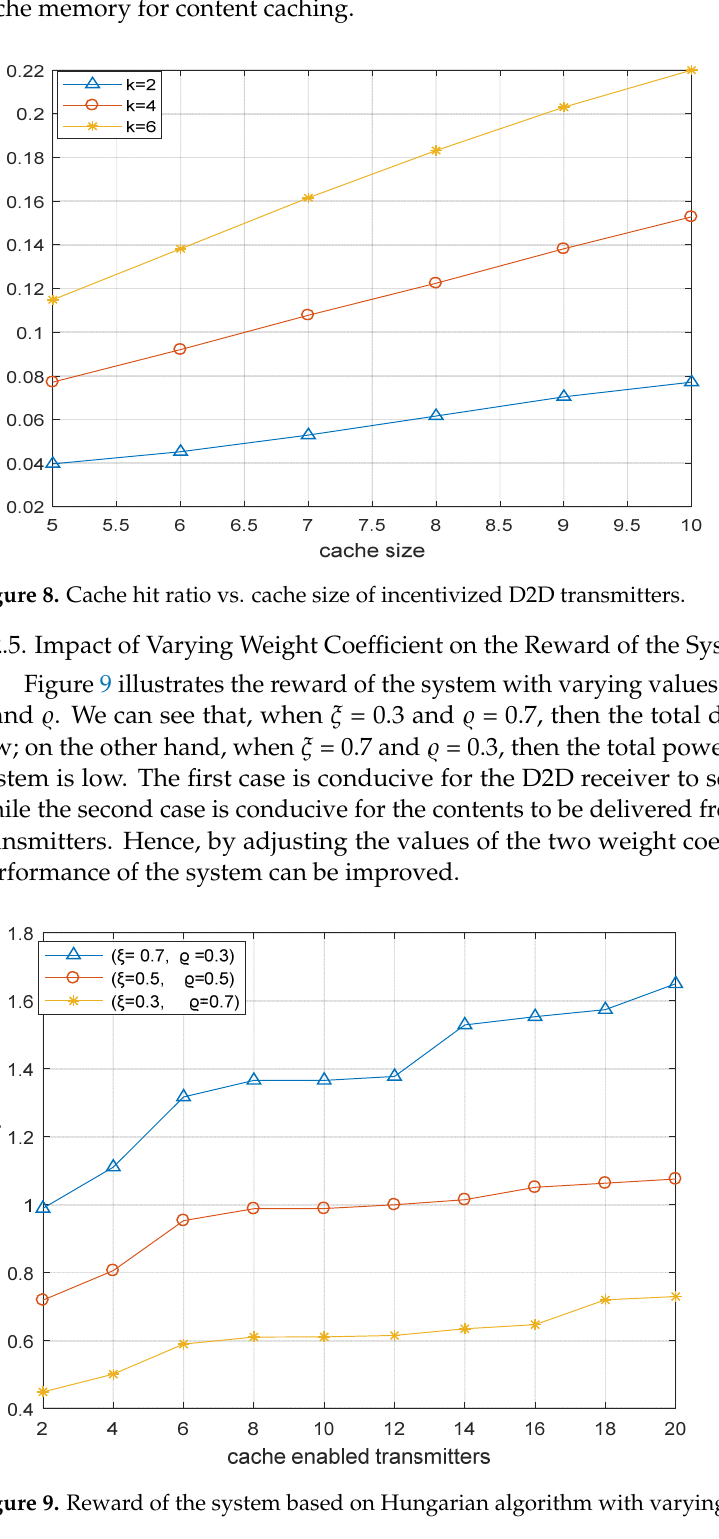
Figure 9. Reward of the system based on Hungarian algorithm with varying weight coefficients.